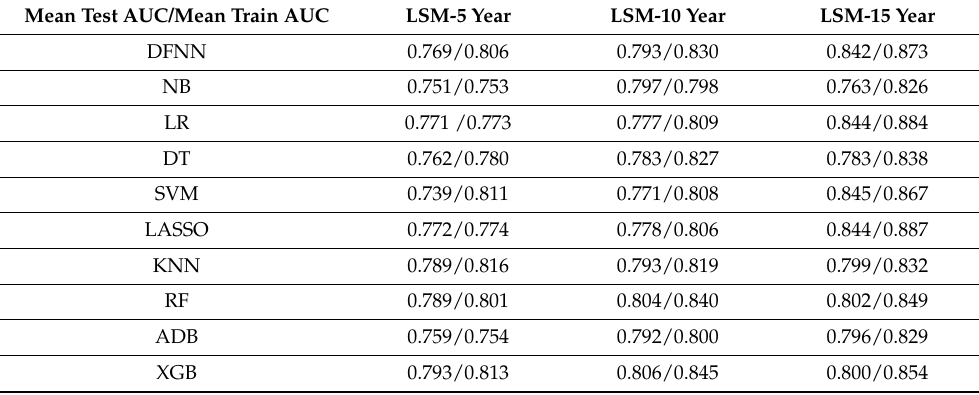
Table 3. The mean test AUCs and mean train AUCs of the best-performing models (LSM: Lynn Sage Dataset for Metastasis; DFNN: Deep feedforward neural network; NB: Naïve bayes; LR: Logistic regression; DT: Decision tree; SVM: Support vector machine; LASSO: Least absolute shrinkage and selection operator; KNN: K-nearest neighbor; RF: Random forest; ADB: AdaBoost; XGB: XGBoost). Mean Test AUC/Mean Train